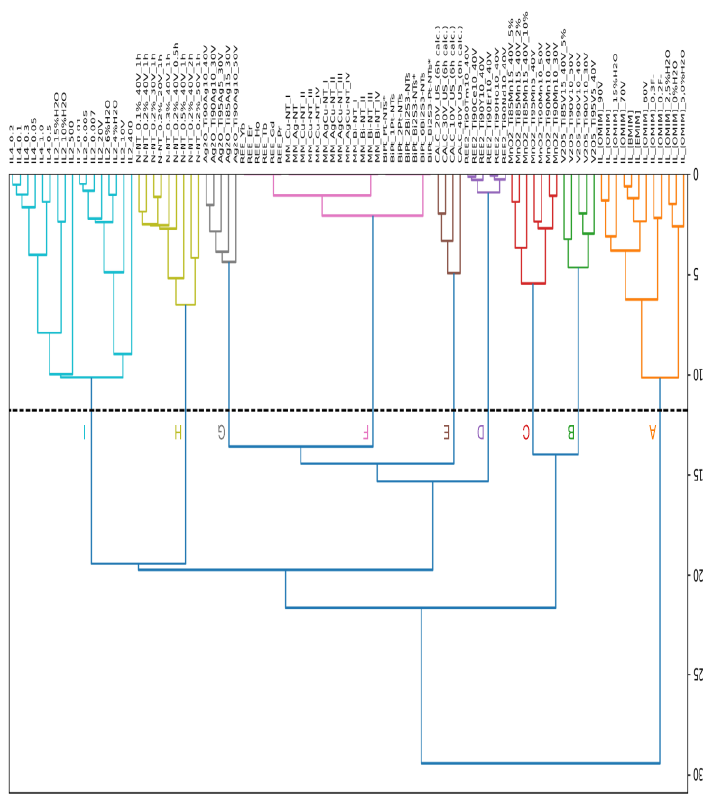
Figure 1. The schematically represented Hierarchical Cluster Analysis (HCA) for selecting groups of similar TiO 2 -based NTs active under VIS and UV-VIS